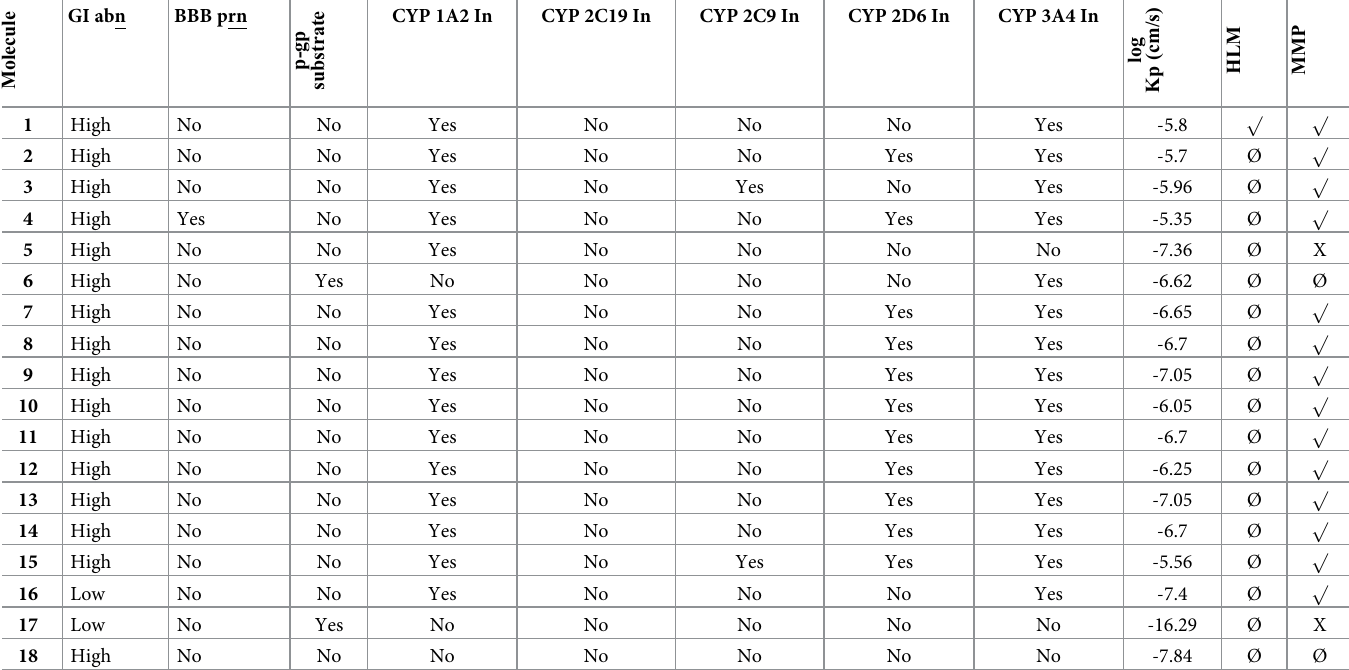
Table 4. The interaction of target flavonoids with cytochromes P450 isoforms predicted using SwissADME. ec l M o